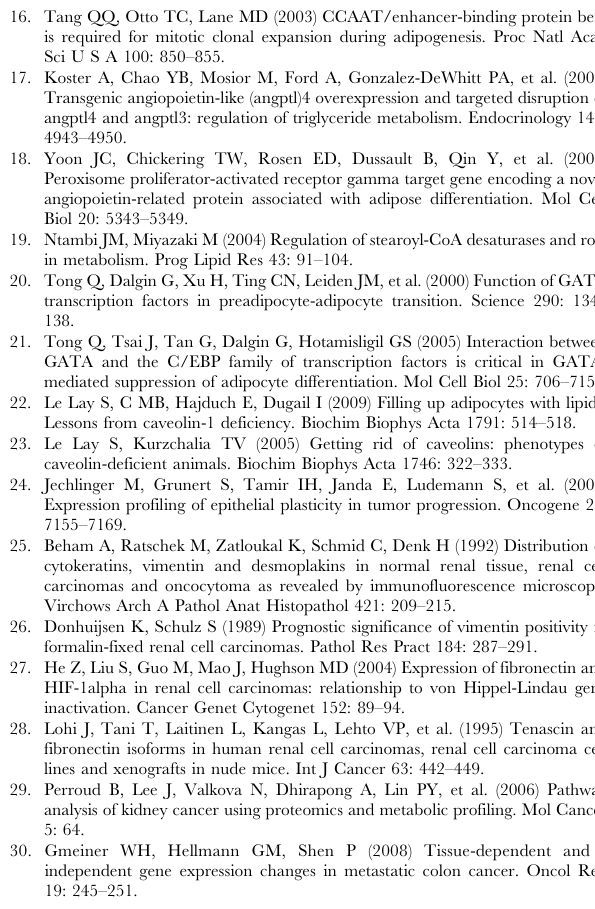
Figure S3 An epithelial mesenchymal transition (EMT) gene expression signature of ccRCC is identified. Normal denotes normal renal samples. Gene expression data are from a publicly available database, GSE # 15641, deposited at Gene Expression Omnibus (GEO). Details on the clustering method are mentioned in the text. Red color indicates an upregulation of genes, green indicates a downregulation, and black indicates a similar expression. Found at: doi:10.1371/journal.pone.0010696.s004 (0.66 MB